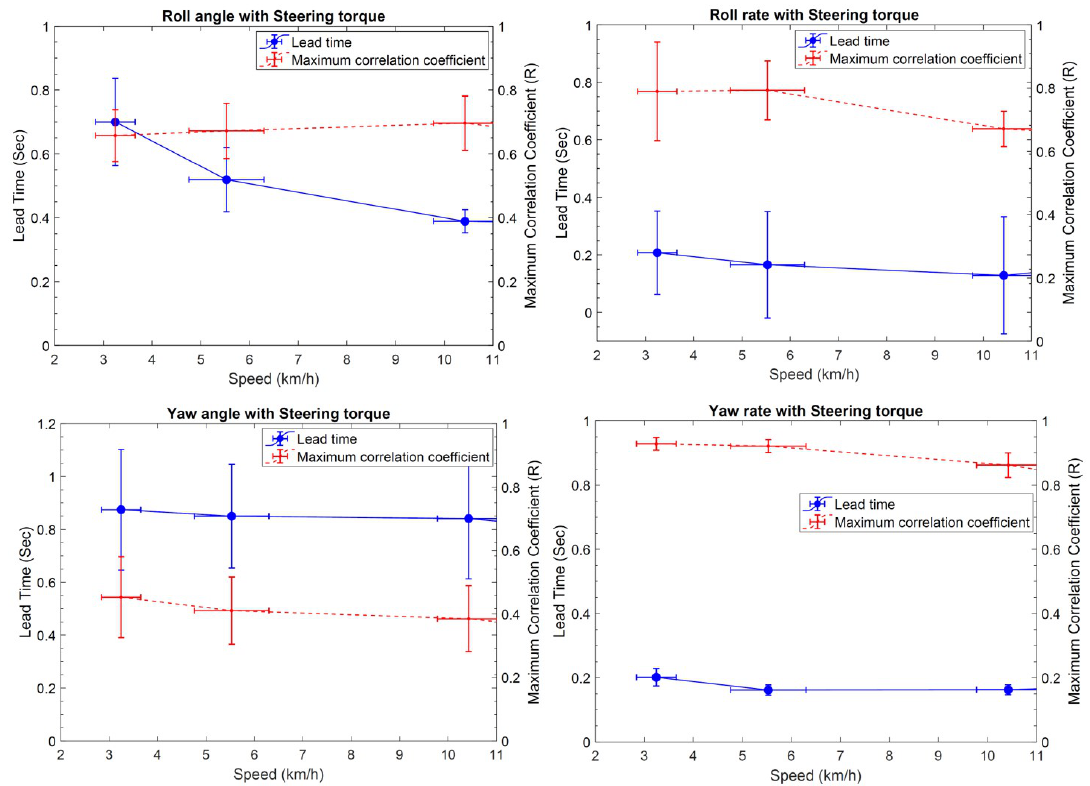
Figure 10. Maximum correlation coefficient (MCC) (R) and lead time for output parameters with steering